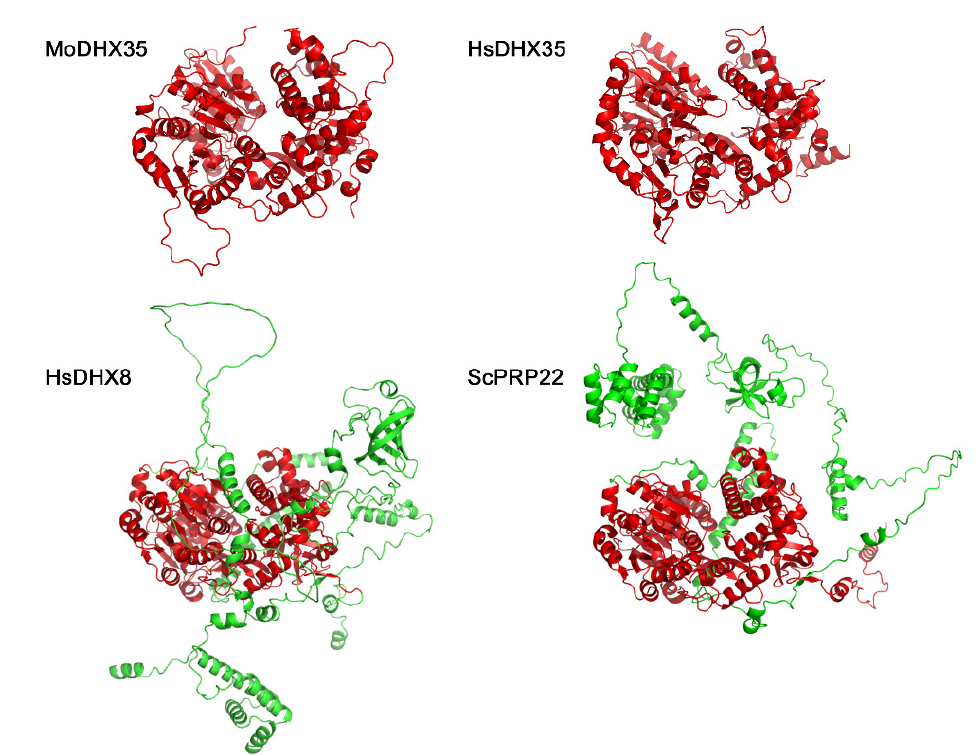
Figure 2. Three-dimensional structures of MoDHX35 , HsDHX35 , HsDHX8 and ScPRP22 generated by the structure prediction server AlphaFold2 database (https://www.cloudam.cn/v2/console/create-job, accessed on 1 December 2021). The conserved portions of the proteins are in red.